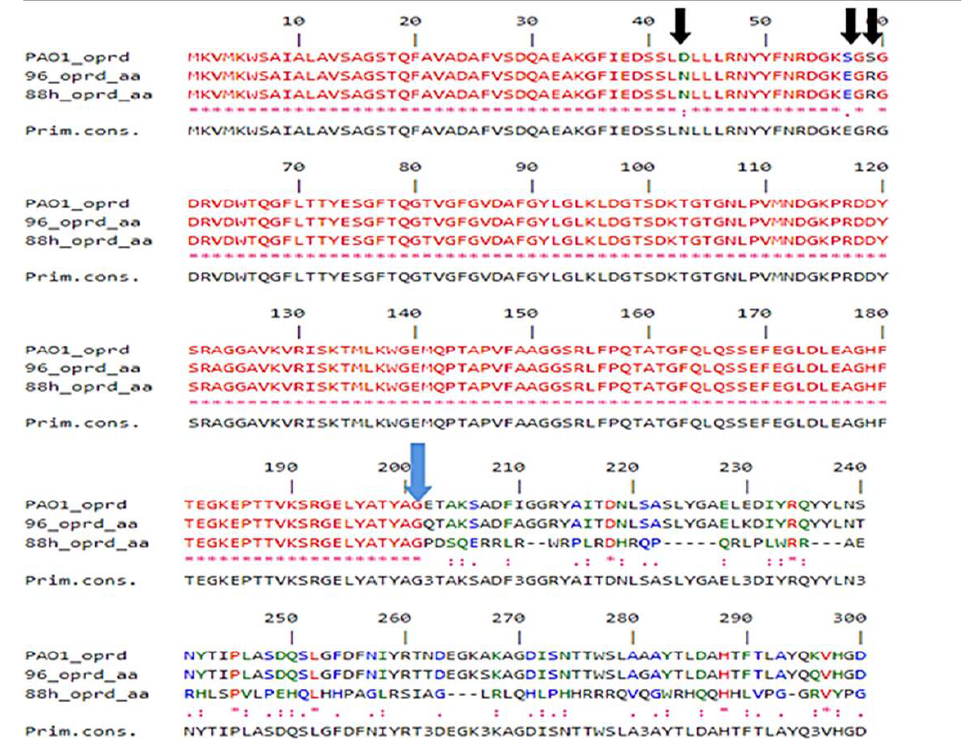
Figure 1. Protein Comparison by NPSA-CLUSTALW between our sequences of OprD gene with wild-type porin sequence from strain PAO1.